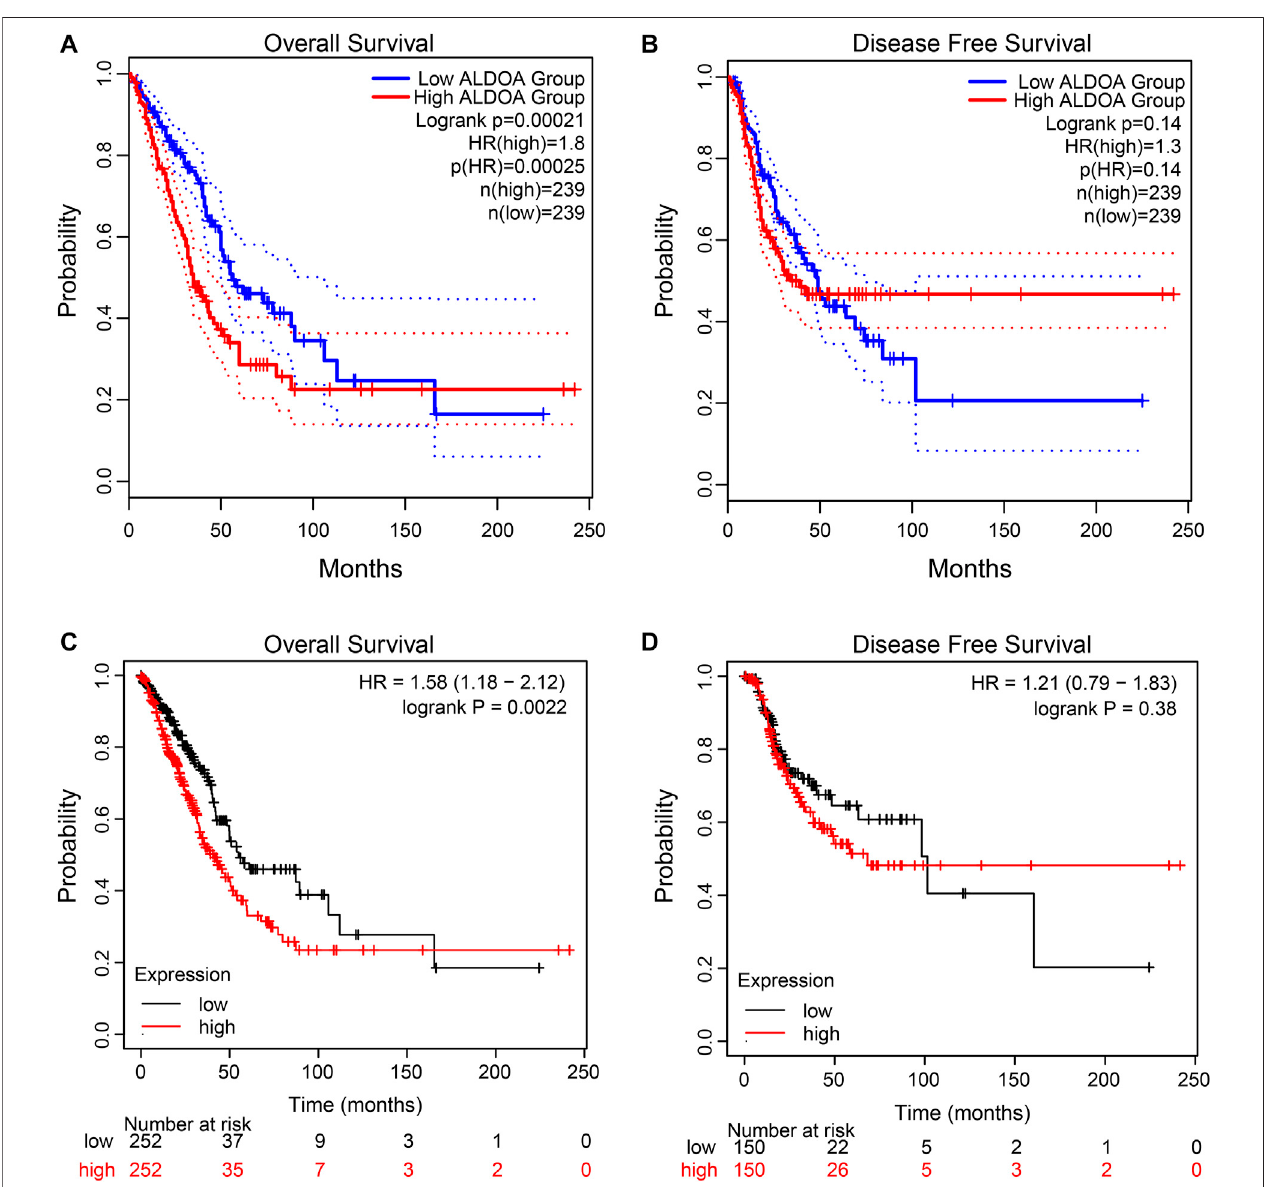
FIGURE 5 | Kaplan-Meier curves for ALDOA in lung adenocarcinoma (A) Higher ALDOA led to shorter overall survival from GEPIA2 (B) ALDOA had no correlation with disease-free survival from GEPIA2 (C) High ALDOA was correlated with short overall survival from the Kaplan Meier plotter (D) ALDOA had no correlated with recurrence-free survival from the Kaplan Meier